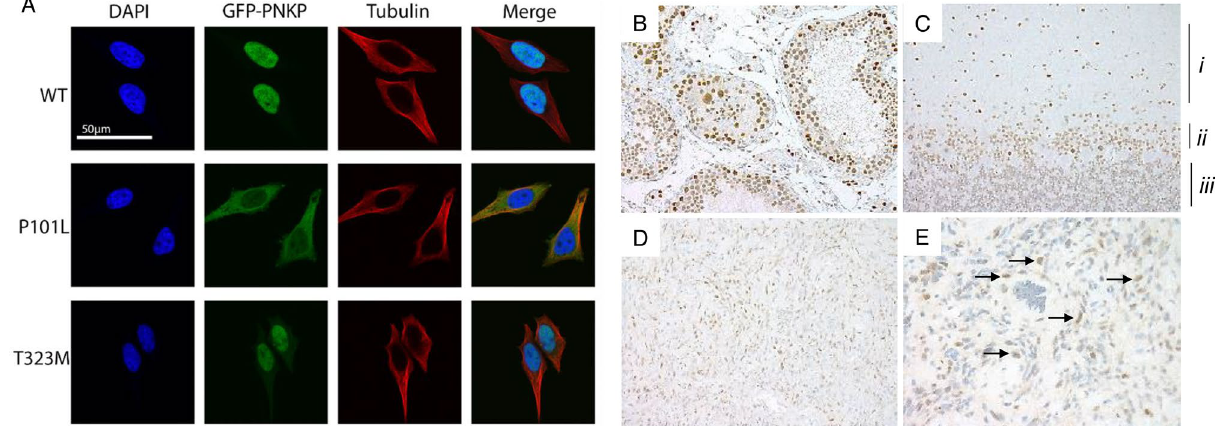
Figure 3. Cellular localization of PNKP. ( A ) HeLa PNKP −/− cells were stably transfected with indicated GFP- tagged PNKP constructs (green), tubulin immunofluorescence (red) indicates the cytoplasmic area, Hoechst staining (blue) indicates the nuclear area. Images were captured using an LSM710 confocal microscope. ( B , C ) PNKP protein expression is restricted to the nucleus in normal tissue (b—Testes, c—Cerebellum. I—Molecular layer, ii—Purkinje layer, iii—granular layer). ( D , E ) PNKP expression in the patient derived tumor tissue is nuclear and cytoplasmic (higher magnification image with back arrows in E